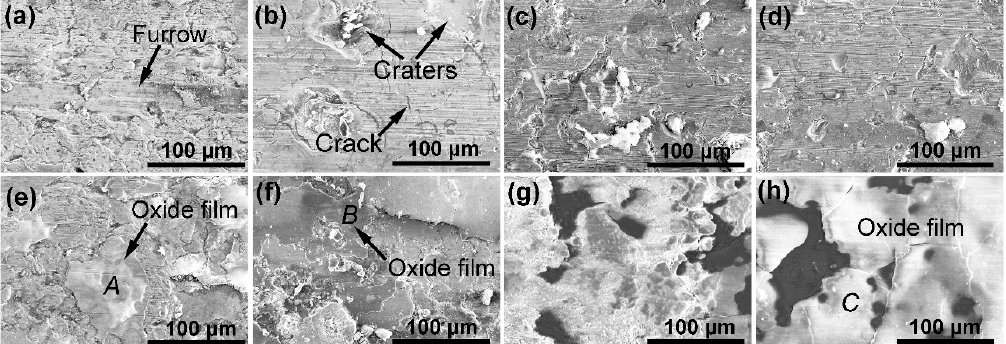
Figure 4. Worn surface of the coatings with different normal loads: ( a ) the substrate at 20 N; ( b ) the Fe 65 P 5 Si 9 B 10 coating at 20 N; ( c ) the Fe 65 P 5 Si 9 B 10 Cr 10 coating at 20 N; ( d ) the Fe 65 P 5 Si 9 B 10 Cr 10 Nb 1 coating at 20 N; ( e ) the substrate at 100 N; ( f ) the Fe 65 P 5 Si 9 B 10 coating at 100 N; ( g ) the Fe 65 P 5 Si 9 B 10 Cr 10 coating at 100 N; and ( h ) the Fe 65 P 5 Si 9 B 10 Cr 10 Nb 1 coating at 100 N.